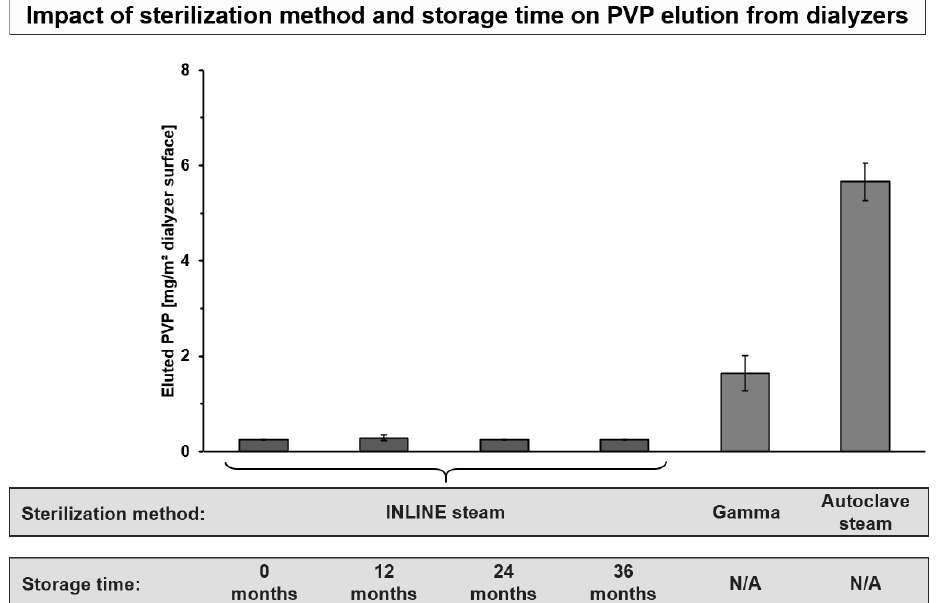
Figure 4. Impact of sterilization method and storage time on PVP elution from dialyzers. Comparison of the amount of eluted PVP in a recirculation system with water for 4 h, as described before [69]. Displayed is the blood-side PVP elution from the INLINE steam sterilized dialyzer FX CorAL 600 (Fresenius Medical Care; n = 9) over shelf life as compared to gamma (xevonta Hi 15, B. Braun and ELISIO 17H, Nipro; n = 3 each) and autoclave steam (Polyflux 170H, Baxter and Theranova 400, Baxter; n = 3 each) sterilized dialyzers, reanalyzed from recently published data [69]. The PVP detection limit for the respective method is 0.5 mg/L; in case of results below detection limit, data are presented as half of the detection limit, as described before [69]. N/A: For these gamma and autoclave steam sterilized dialyzers, no data over shelf life was available; measurement was performed at one time point within their specified shelf life.